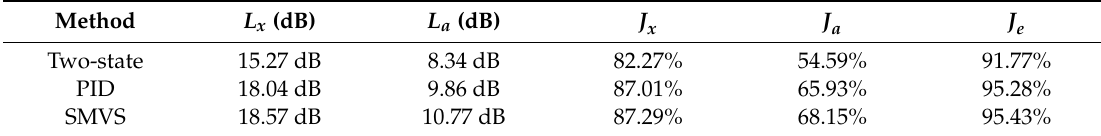
Figure 18. Vibration characteristics of the different pipeline vibration control modes: ( a ) Vibration level difference of displacement; ( b ) Vibration level difference of acceleration; ( c ) Attenuation rate of displacement; ( d ) Attenuation rate of acceleration. Table 5. Vibration level difference of the three control methods.